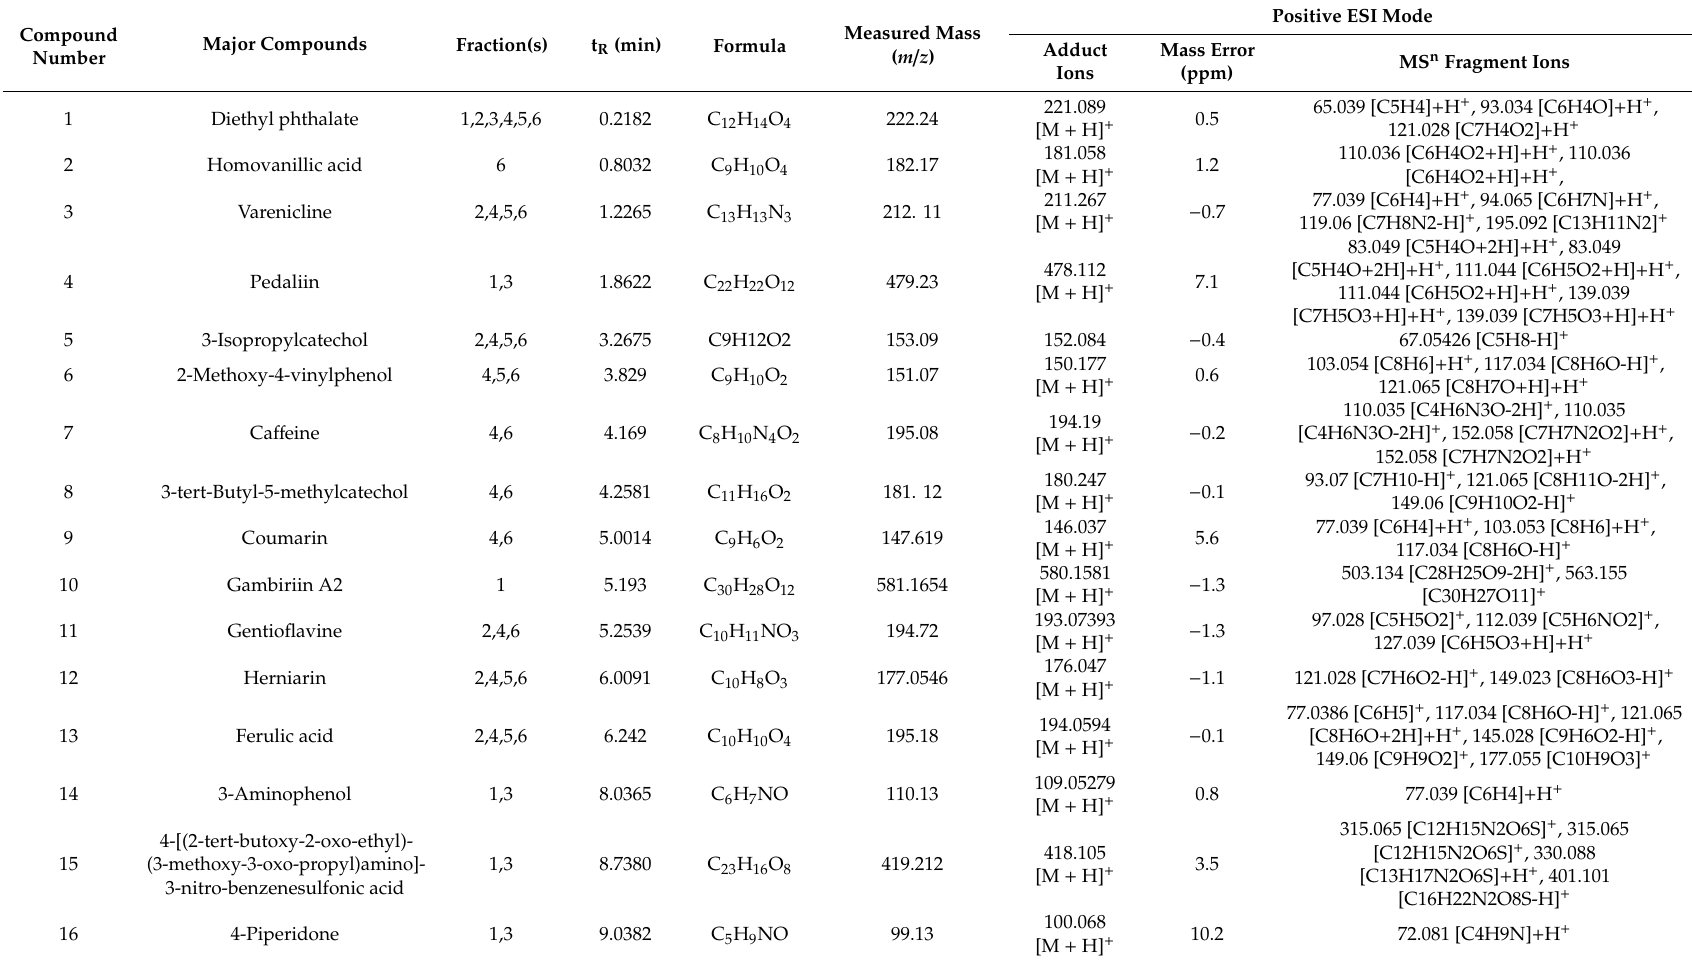
Table 5. Retention time (RT), measured mass, and calculated formula by elemental compositions for major compounds identified in the